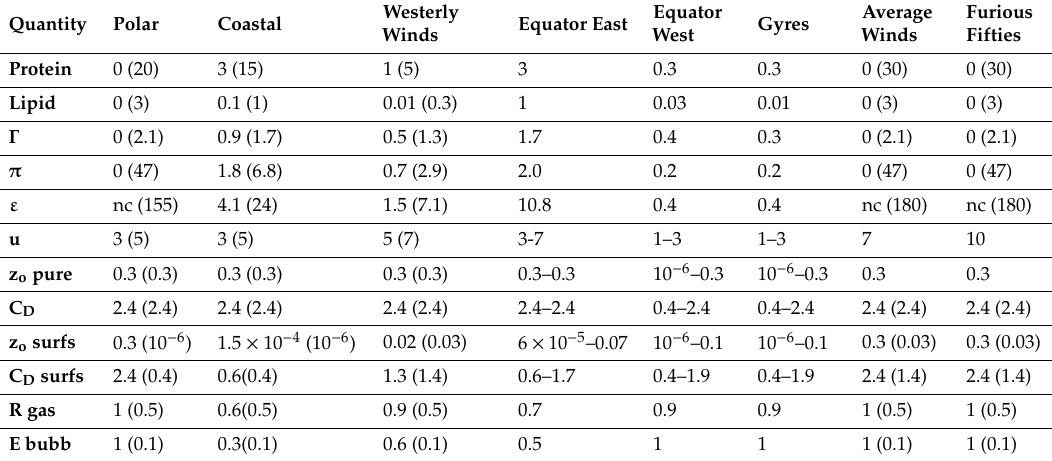
Table 3. Linking marine surfactant concentrations to climate-critical fluxes. Methods and definitions are provided in the text, with details referenced from standard surfactant chemistry monographs and our earlier work. Ecogeographic zones in the top row are agglomerates from the system cited in the Introduction. Moving down the first column units are: the surfactants as µ M carbon, excess or coverage in mg / m 2 , two-dimensional (2D tangential) pressure π mN / m or mJ / m 2 , elastic modulus ε same as pressure, wind in m / s, roughnesses given in cm. Drag coe ffi cients are listed in units of 10 − 3 dimensionless, while R, the ratio of piston velocities (surfactant to clean interface) is dimensionless, and E, a relative e ffi ciency for particle number per m 2 of bursting film, likewise has no units. Any parentheses indicate a local phytoplanktonic bloom situation, nc means that the fractional di ff erential area change was not computed, and dashes correspond to the quoted wind speed